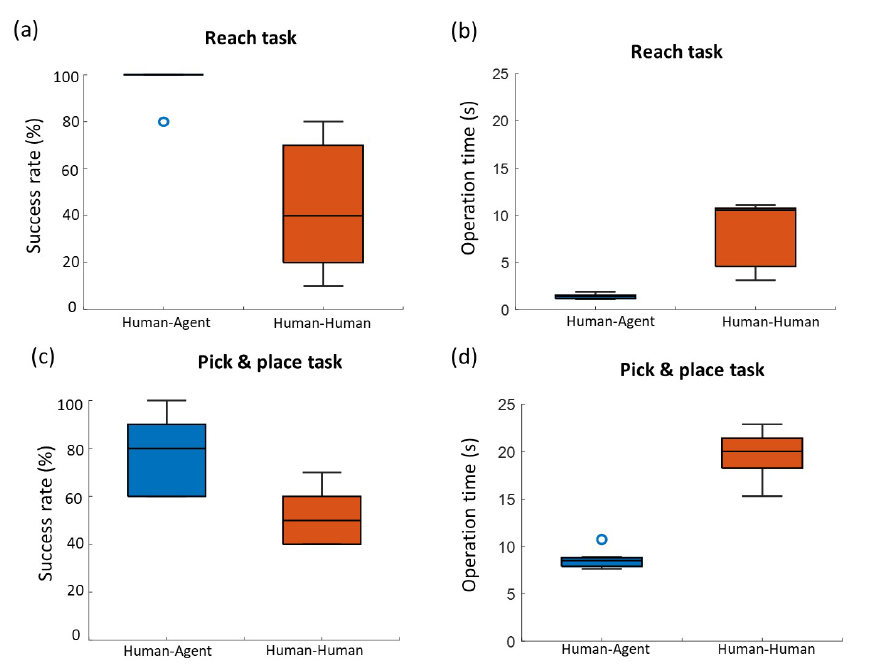
Figure 10. Subjects’ performance result of reaching task in ( a ) success rate and ( b ) operation time; and the P&P task in ( c ) success rate and ( d ) operation